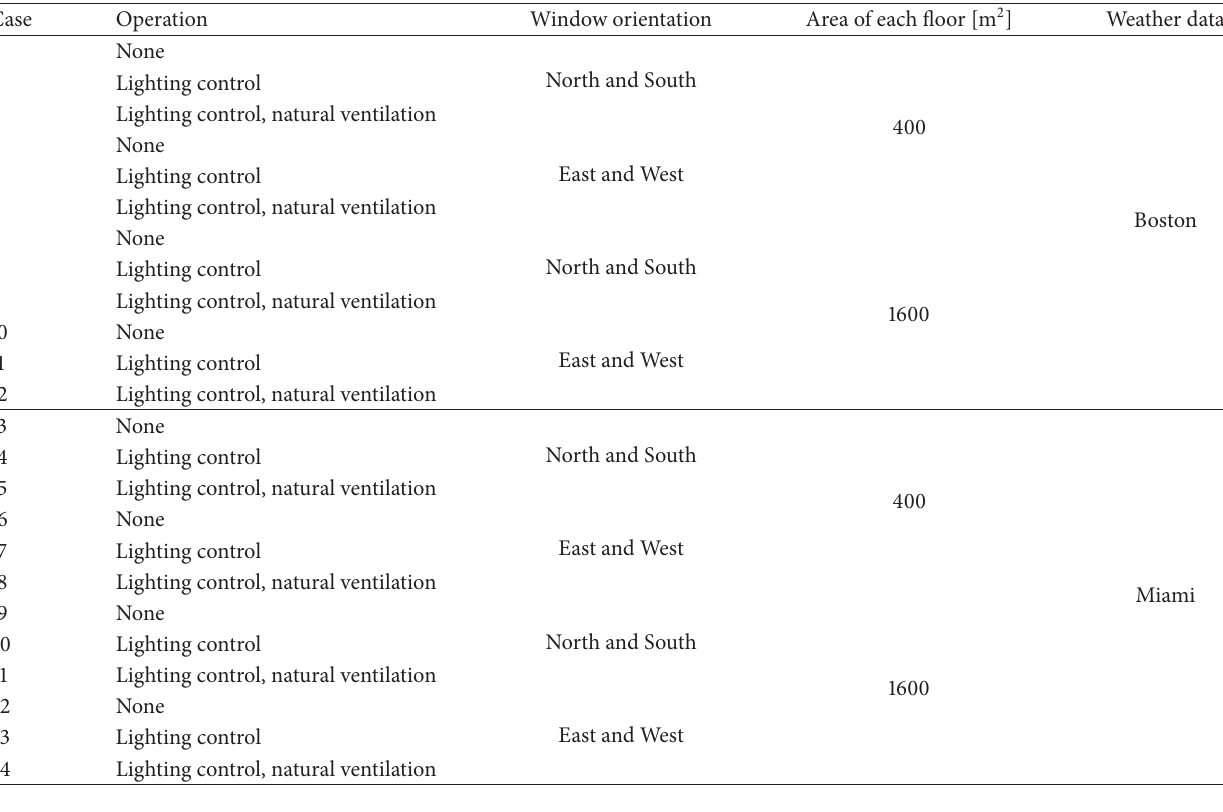
Table 1: Variable conditions for the case studies.